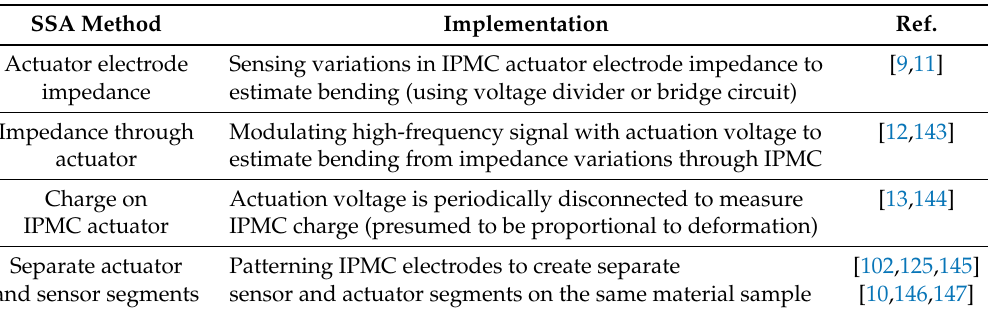
Table 2. Self-sensing actuation methods for IPMCs.